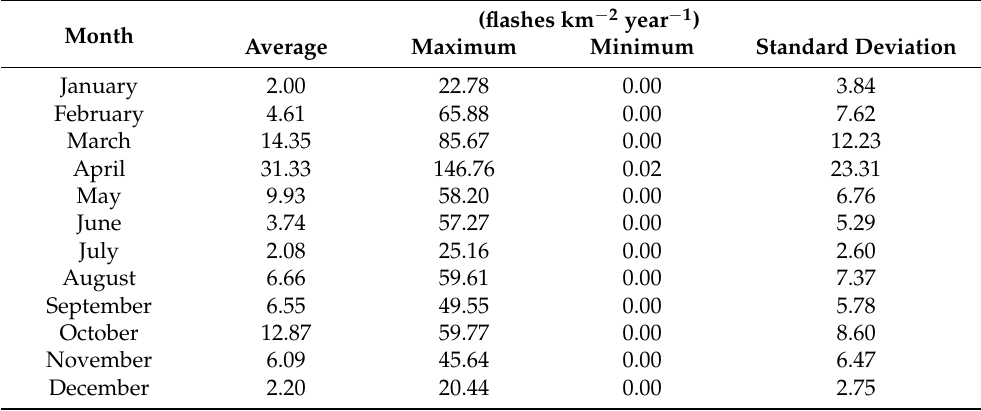
Table A4. Statistics of the monthly variations of the lightning flash density, based on the 1998–2014 LIS Data from the TRMM Satellite.